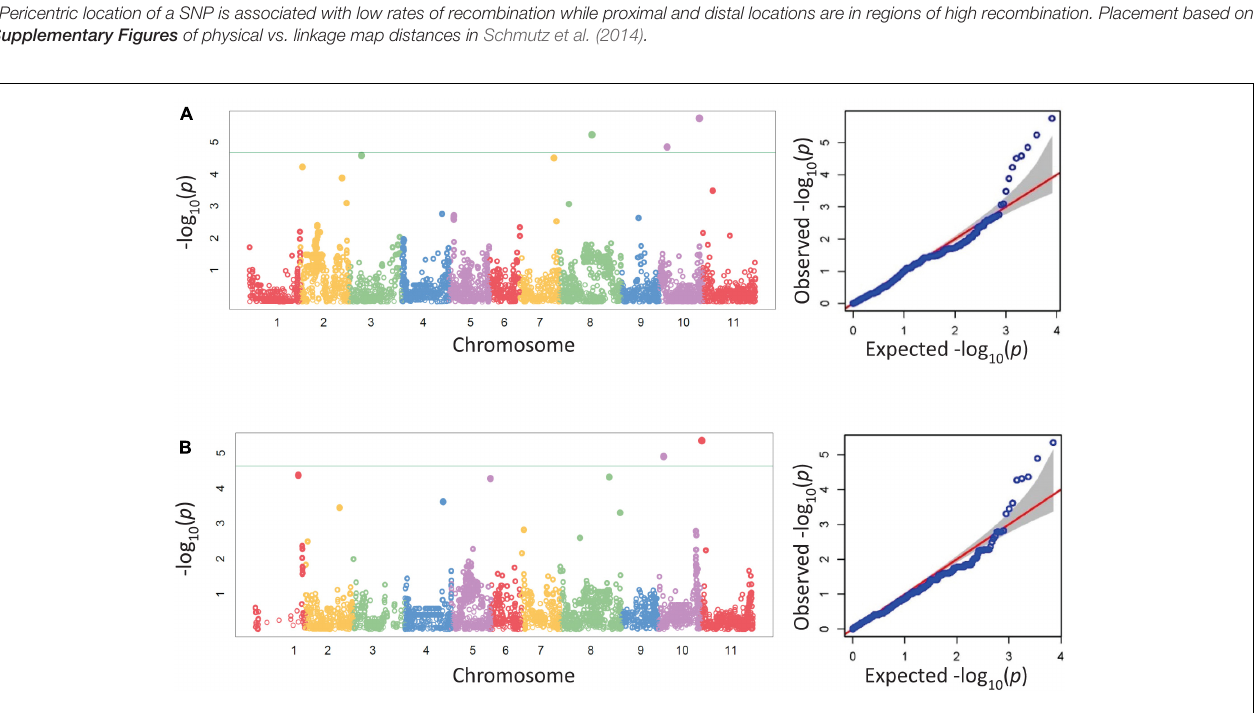
TABLE 6 | Putative candidate genes within 350 kb of the associated SNP for Fusarium solani root rot disease severity and plant biomass identified by genome wide association study using the BeanCAP snap bean diversity panel grown at the Oregon State University Vegetable Research Farm near Corvallis. Chrom.